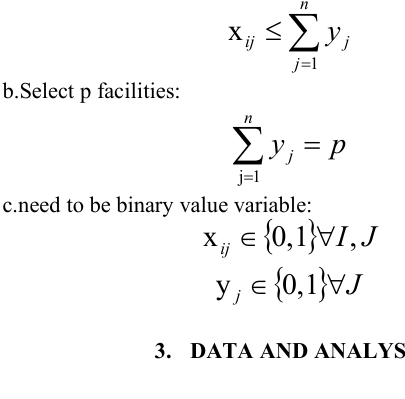
Figure 3. Residents and religious places. Figure. 4. Religious site buffer. Figure 5. Forbidden construction zone.